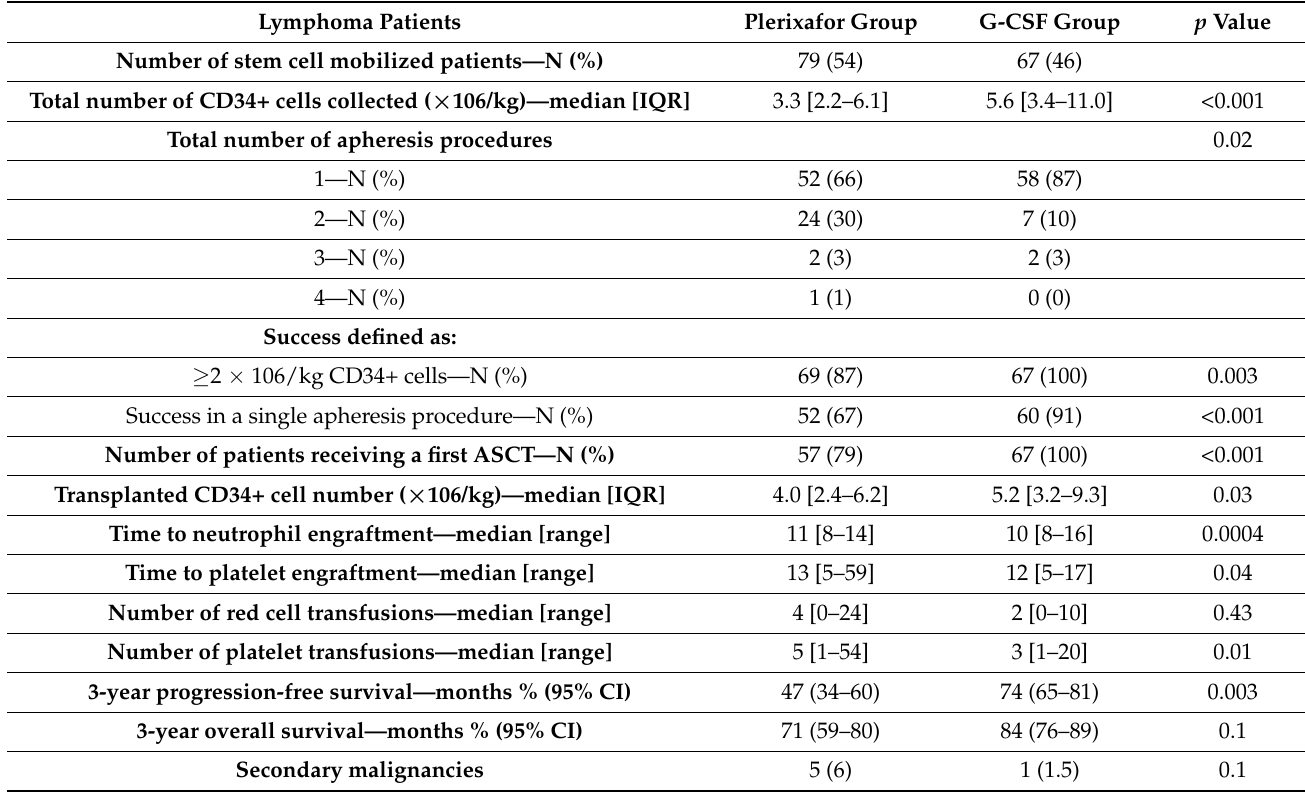
Table 4. CD34+ cell kinetics, engraftment, and outcome in lymphoma patients. Lymphoma Patients Plerixafor Group G-CSF